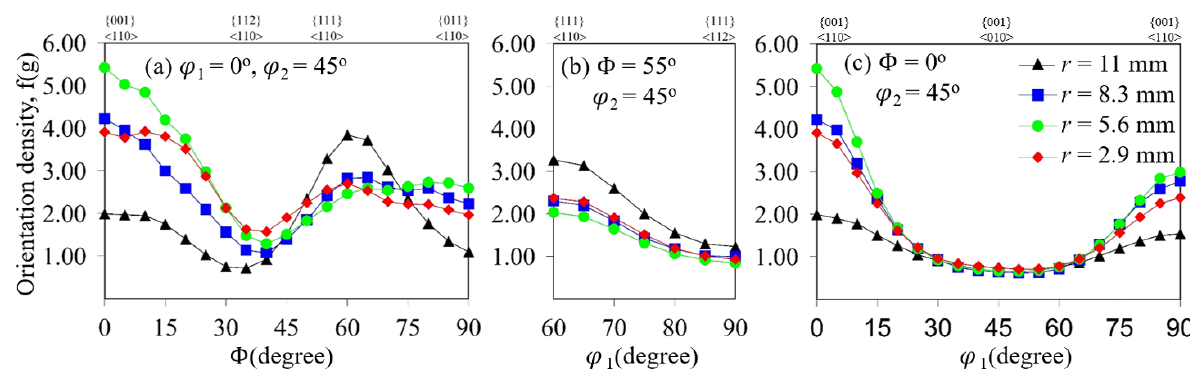
Figure 10. Orientation density distribution along various orientation lines in the forged tube with a reduction of 42.7%: ( a ) α -fiber orientation; ( b ) γ -fiber orientation; ( c ) λ -fiber orientation. Table 5. Volume fractions of the main texture components of the forged tube with a reduction of 42.7%